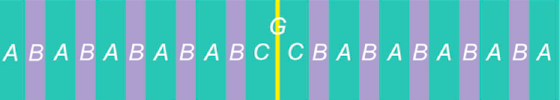
Figure 1. Schematic of defective photonic crystals (PCs). The primitive unit-cell layers A and B array alternatively to form two Bragg gratings. Graphene (G) is embedded in the center of the defect layer